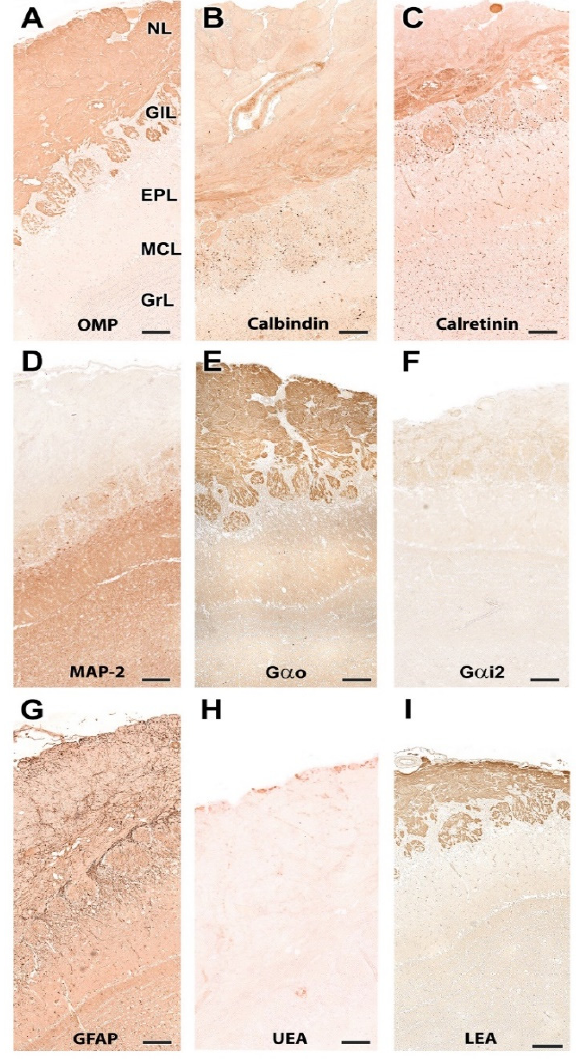
Figure 15. Immunohistochemical and lectin-histochemical study of the OB of the wolf. ( A ) Anti-Olfactory marker protein (OMP); ( B ) Anti-Calbindin; ( C ) Anti-Calretinin; ( D ) Anti-MAP-2; ( E ) Anti-Gao; ( F ) Anti-Gai2; ( G ) Anti-GFAP; ( H ) UEA histochemical labeling; ( I ) LEA histochemical labeling. NL, Nerve layer; GlL, Glomerular layer; EPL, External plexiform layer; MCL, Mitral cell layer; GrL, Granular layer. Scale bars: 100 mm.